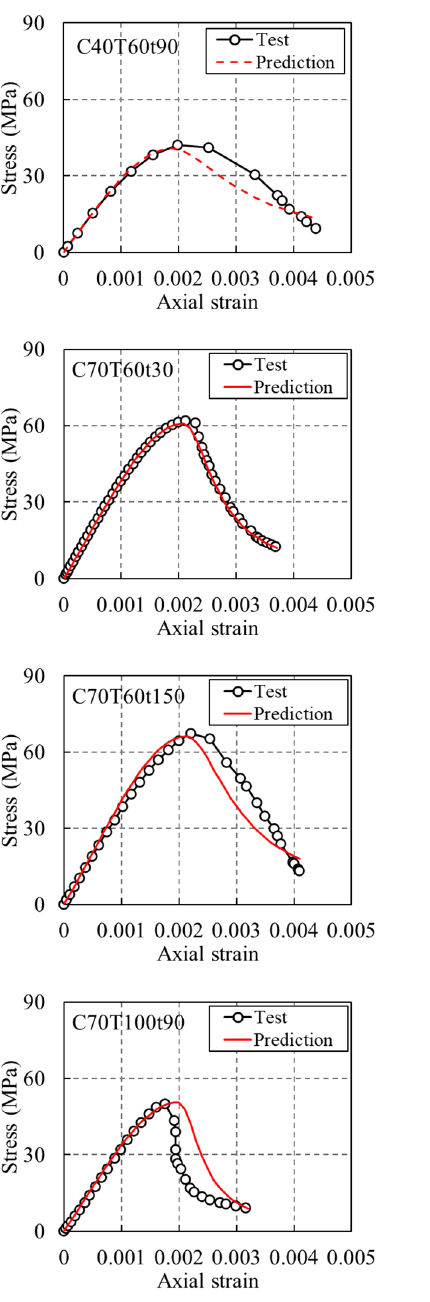
Figure 16. Prediction of stress–strain relationship of SSC subjected to thermal